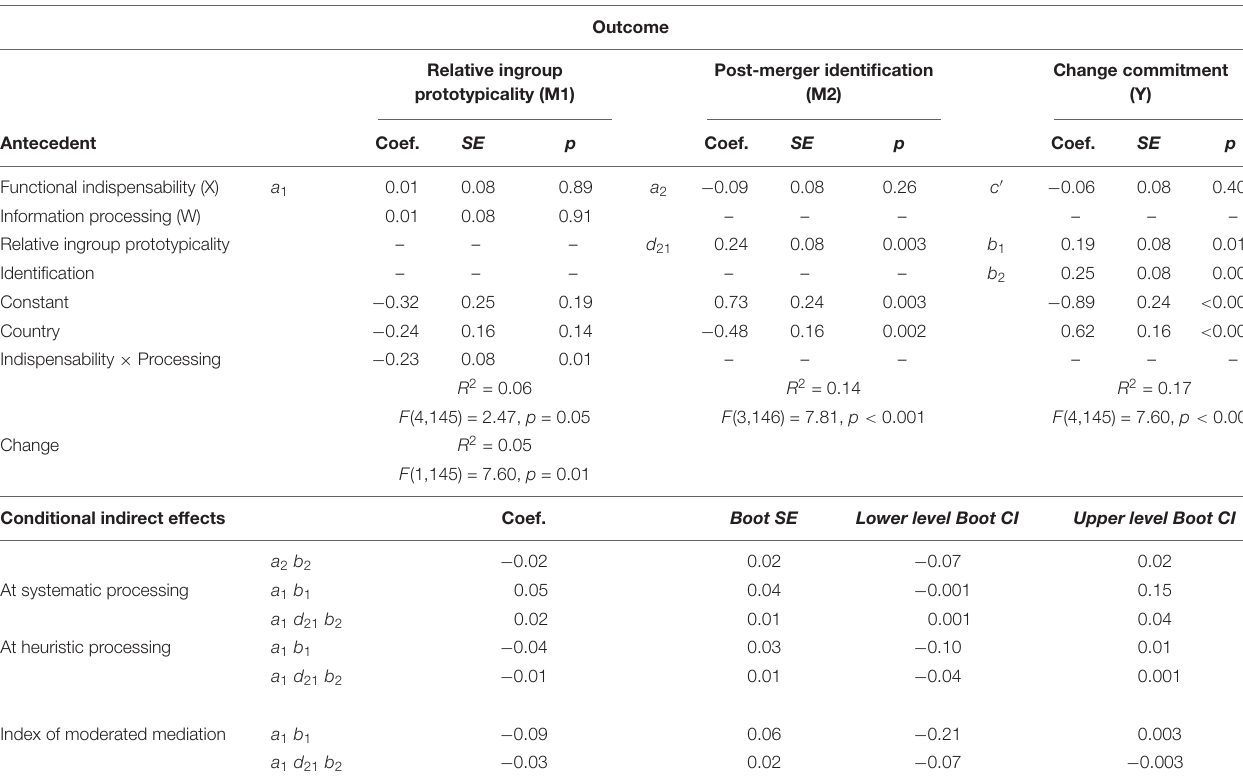
TABLE 3 | Summary of sequential mediation (H2) moderated by information processing, Study 2.